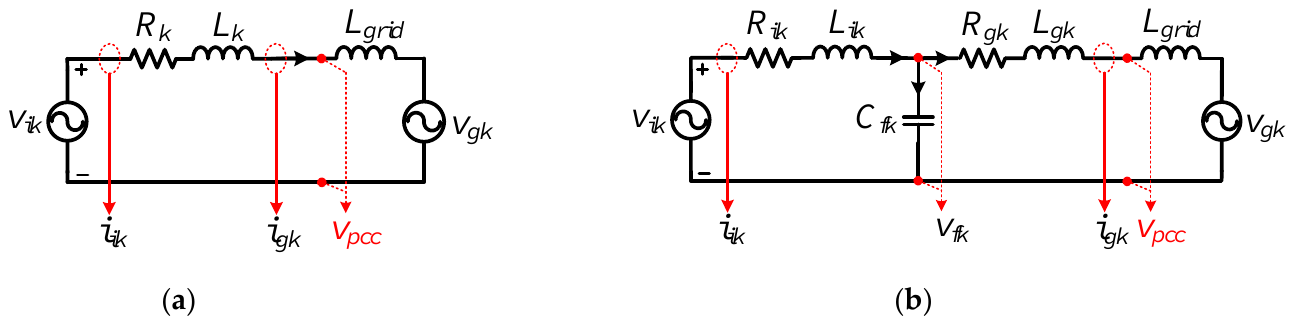
Figure 2a. The inductor L k and equivalent resistor R k are the parameters of the L filter. It is worth noting that sensing either the grid side current i gk or inverter side current i ik results in the same mathematical model [8].